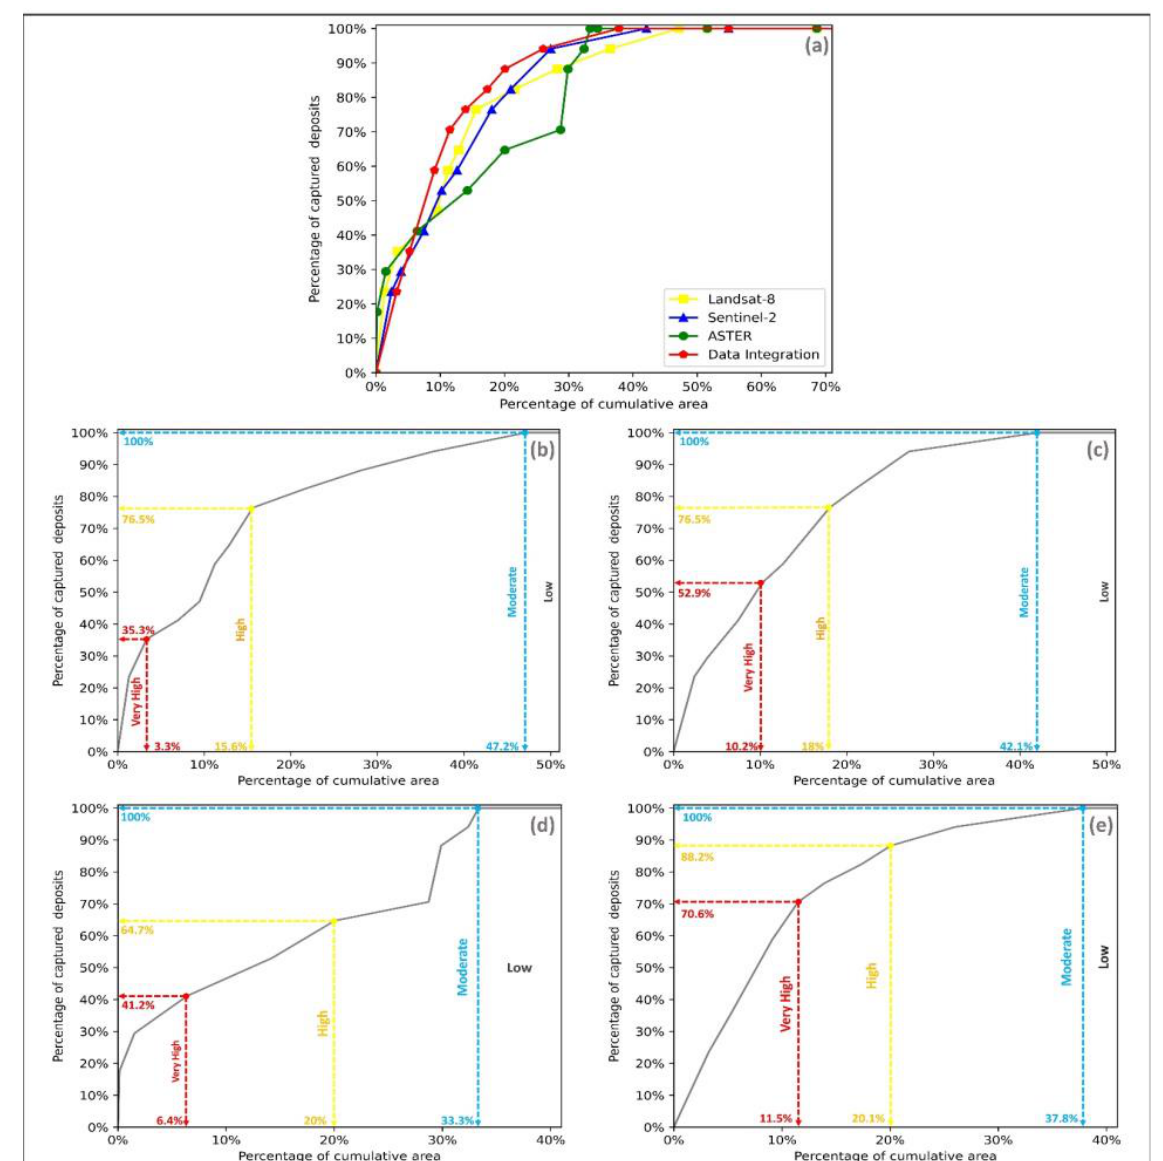
Figure 14. Success-rate curves of RF predictive maps trained using various datasets: ( a ) all success- rate curves; ( b – e ) curve of Landsat-8, Sentinel-2, ASTER, and data integration, respectively.